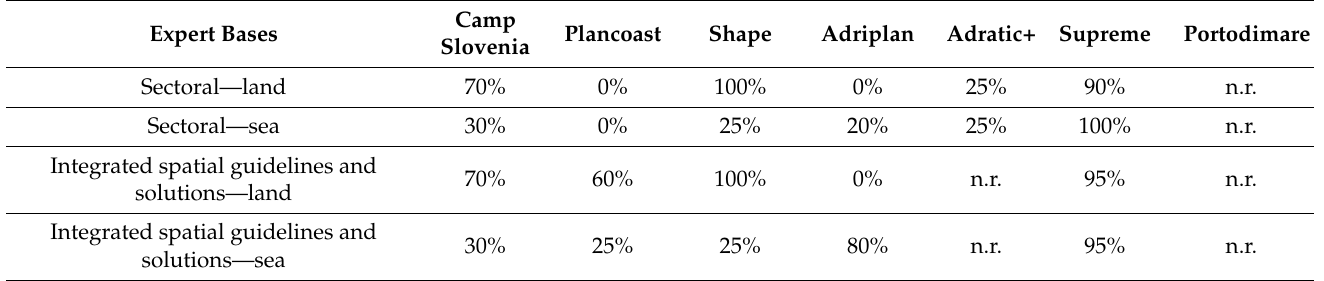
Table 5. Comparison of the draft plan and individual projects: various expert bases for land and sea. Expert